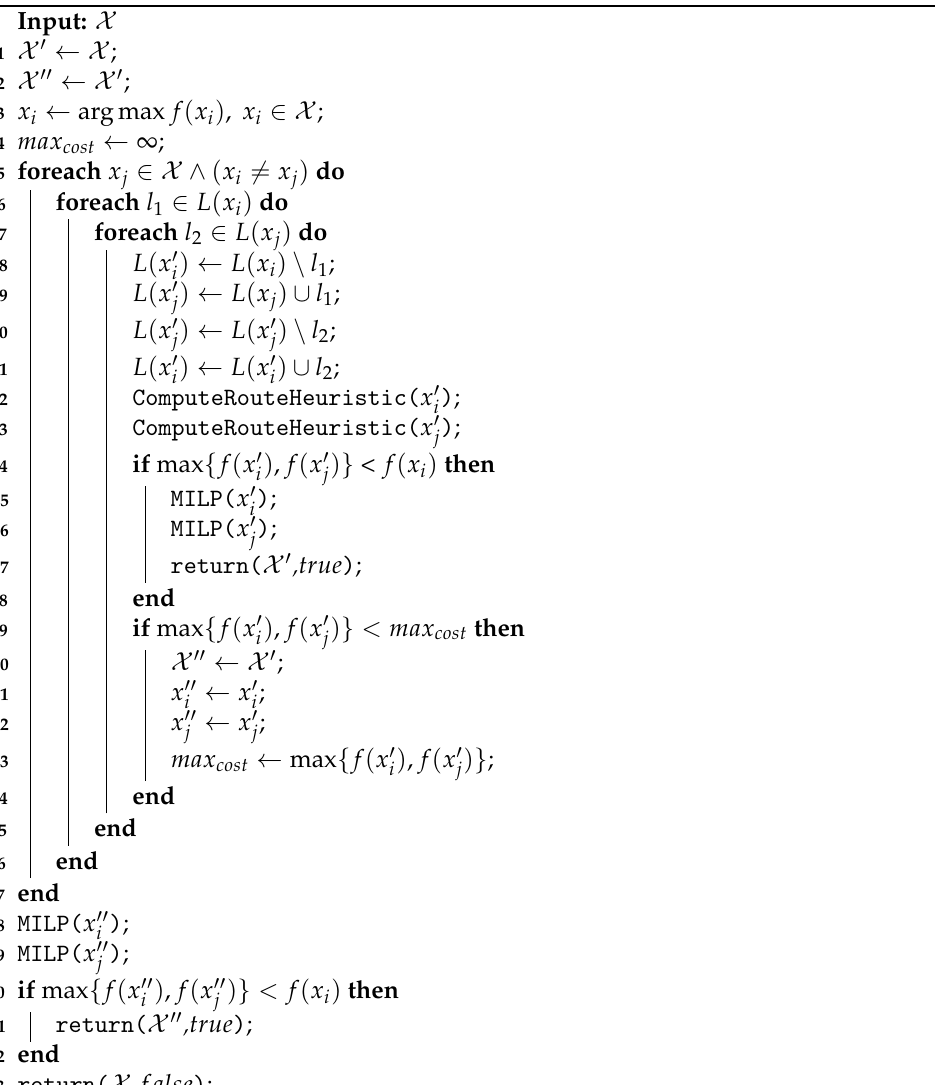
Algorithm 9: Swap performed in